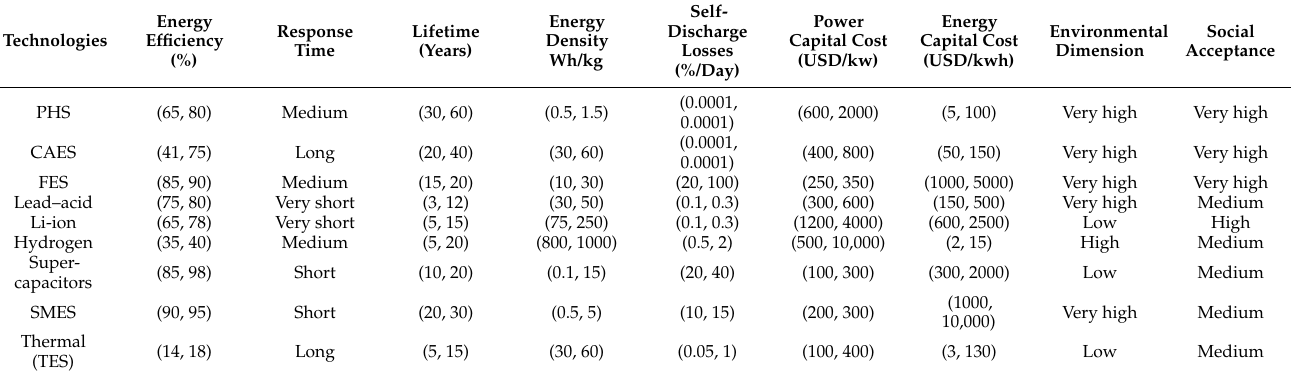
Table A15. Decision basic data of Expert 9.